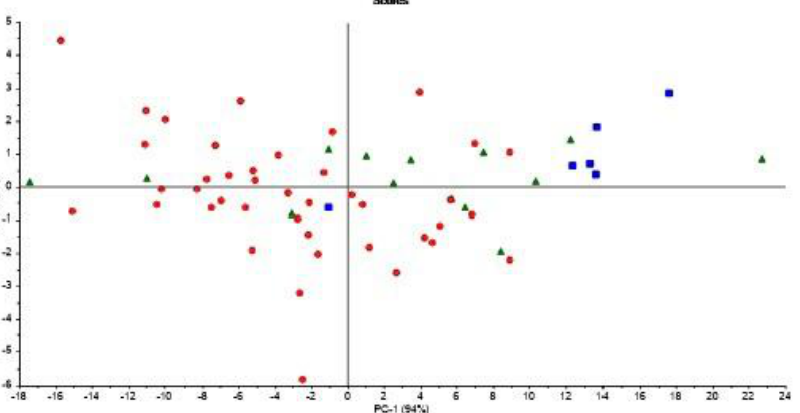
Figure 7. Score plot from PCA of the average of FA’s from the five first milk samples in each 61 lactation in the study. Samples are coded according to normal cows (<1.0 ng/mL, circles), subclinical ketosis cows with BHB values between 1.0 ng/mL and 2.0 ng/mL (triangles), and subclinical ketosis cows with BHB values above 2.0 ng/mL (squares).